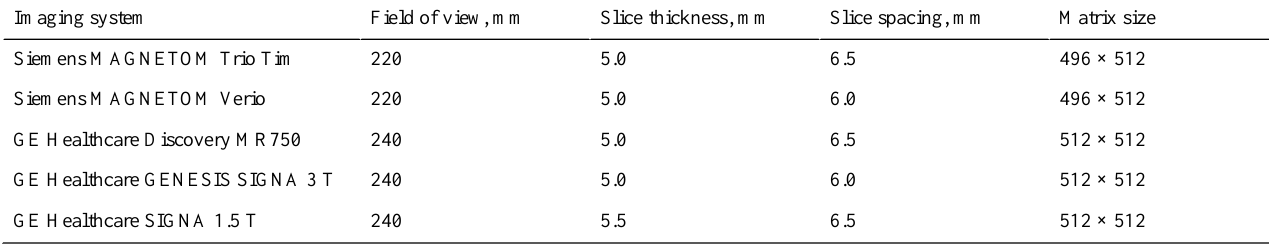
Table 2. Specifications of the imaging data acquired from the different magnetic resonance imaging